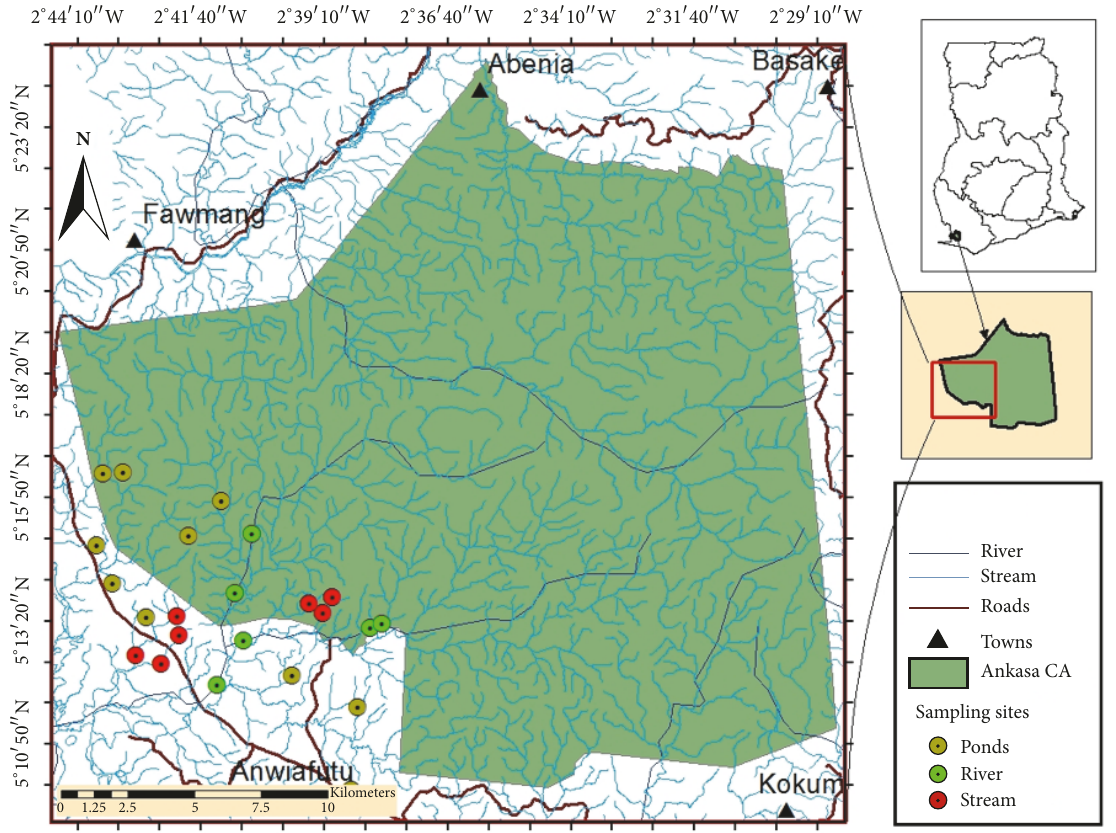
Figure 1: Map of the study area in and near the Ankasa Conservation Area, Western Region, with the situation of the 23 sampling sites of the three water